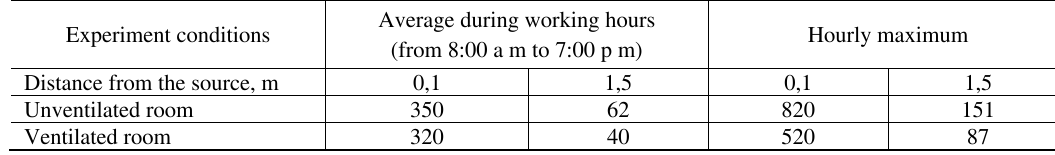
Table 2. Results of horizontal distribution of ozone concentration, μ g/m 3 Experiment